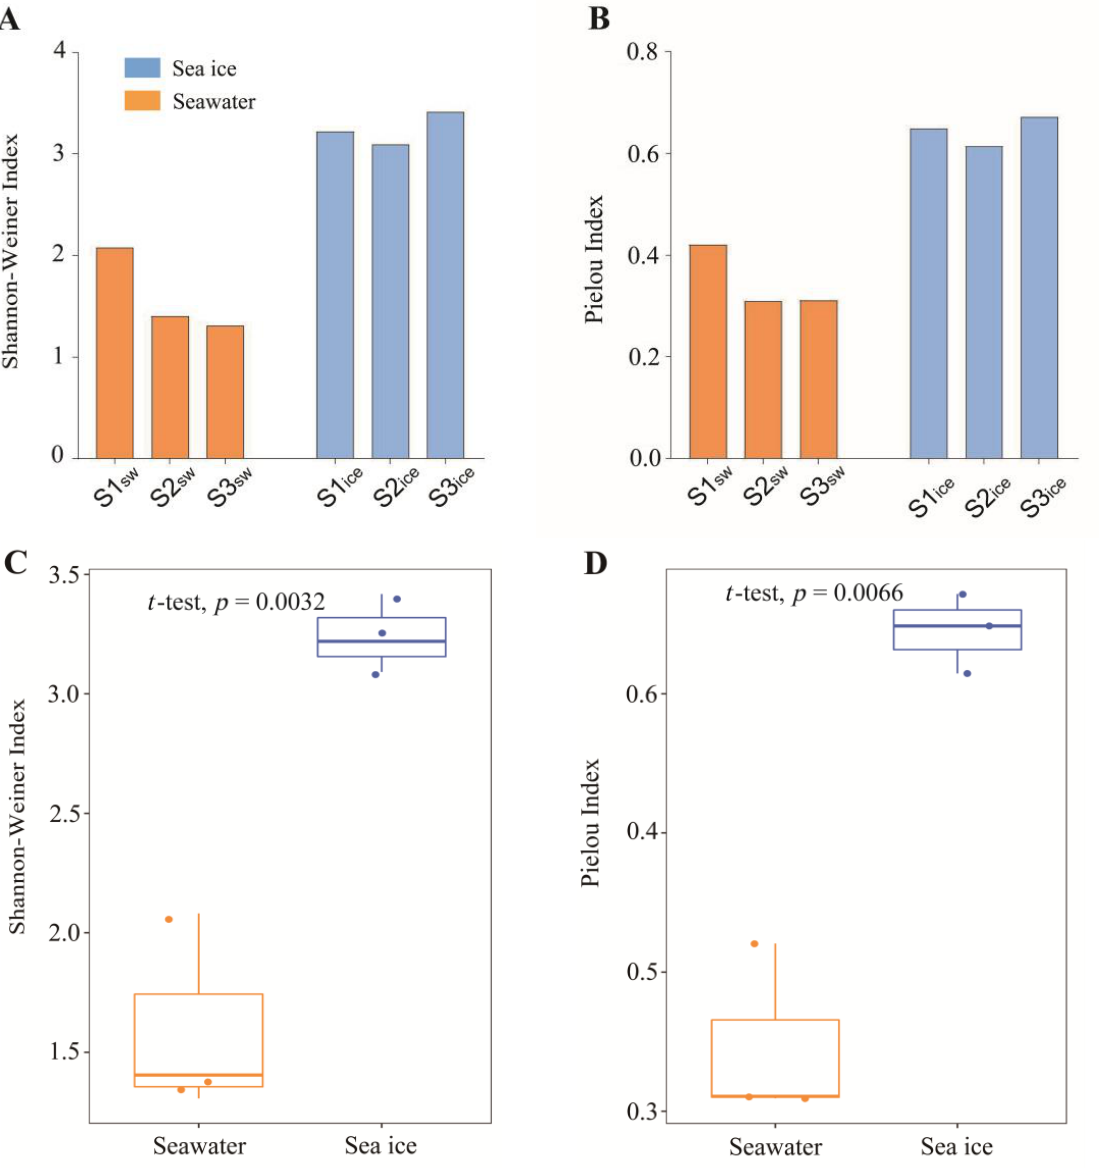
the eukaryotic microalgal community in the sea ice were significantly higher than in the seawater (Figure 2C,D) ( p < 0.05).